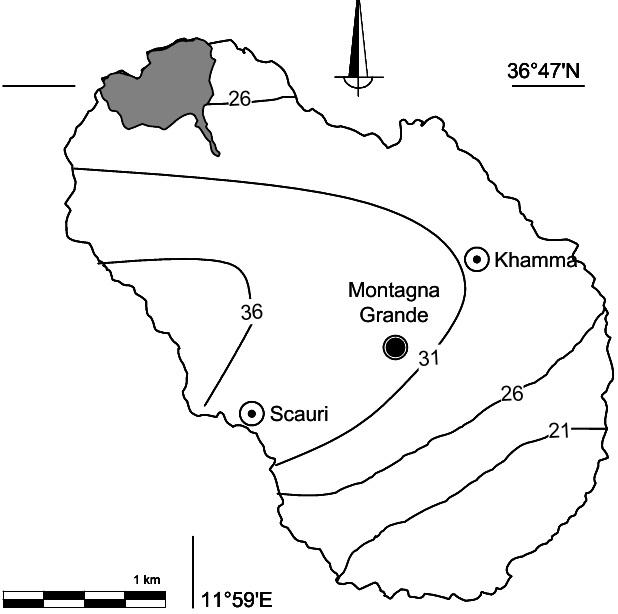
Figure 3. Lines indicate the error of predicted soil total carbon at any depth within 60 cm. Kriged C content is given as a maximum percentage of the error in the extrapolation of the predicted values (n = 89, standardised experimental variogram max lag 3,900 m, direction −